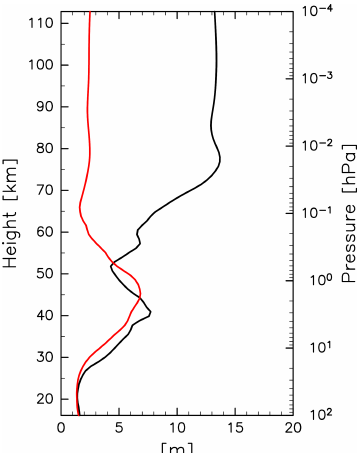
Figure 3. The vertical profiles of standard deviation for small-scale (wavenumber s > 21) components of geopotential height at 70 ◦ N in 00:00UTC on 20 January 2017 at 0.1hPa. Black and red curves denote results from the Ctrl (KSMW20) and Expt. I,